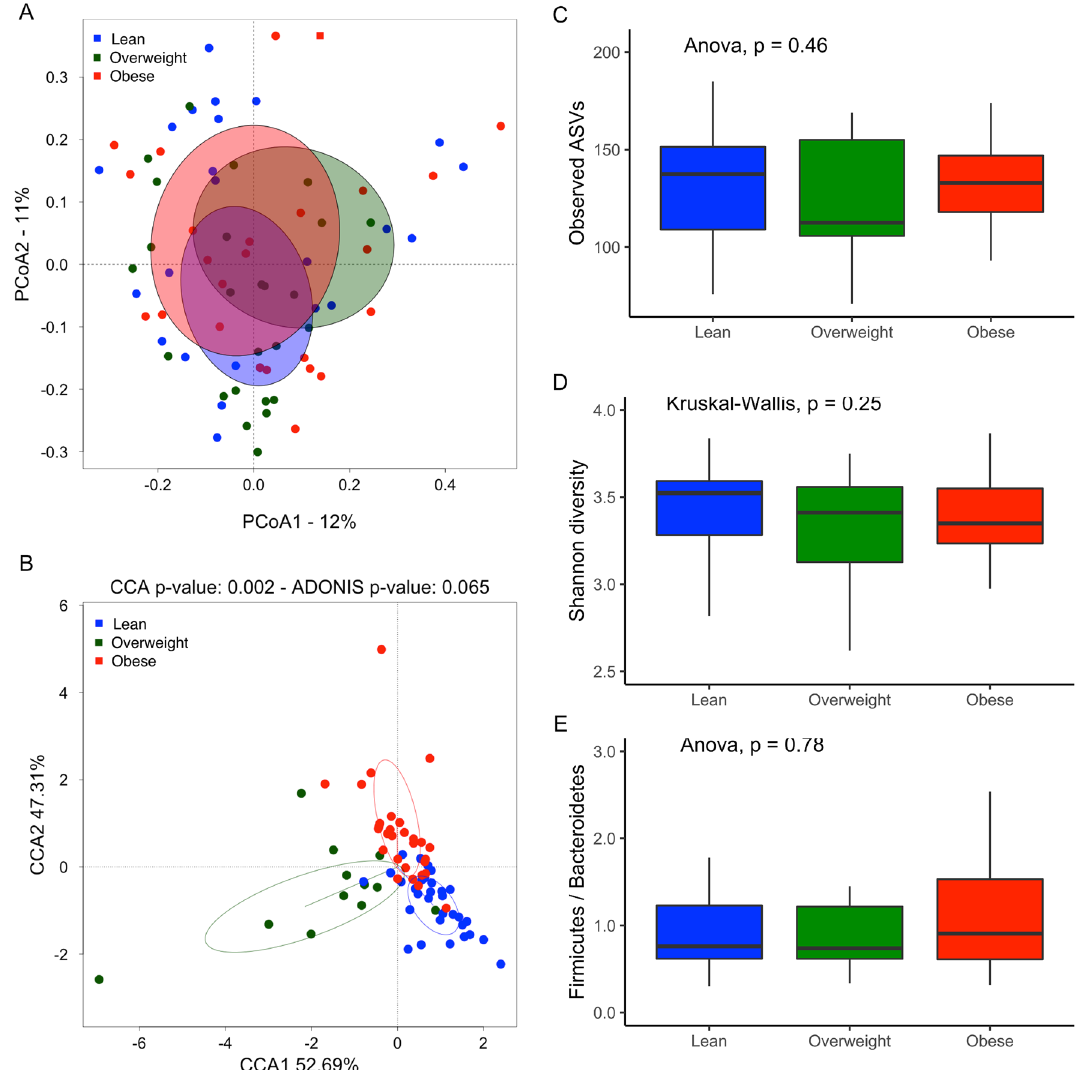
Figure 1. Analysis of the microbiota in the Argentinean population according to their BMI status. ( A , B ) Comparison of the microbiota profiles using the Principal Coordinates Analysis (PCoA) and the Canonical Correspondence Analysis method (CCA) based on the Bray–Curtis distance. The ellipses represent the standard deviation ( C – E ) Box-plots showing the Observed ASV diversity ( B ), the Shannon diversity ( C ), the Firmicutes/ Bacteroidetes ratio ( D ). The solid black lines indicate medians, and the lower and upper bounds of the box represent the 25 and 75% quartiles. Outliers are indicated as black circles and represent samples falling outside the 10 and 90% quartiles. Statistical analysis was performed using the ANOVA test. Each color represents a specific BMI group population: blue box (Lean), green box (Overweight) and red box